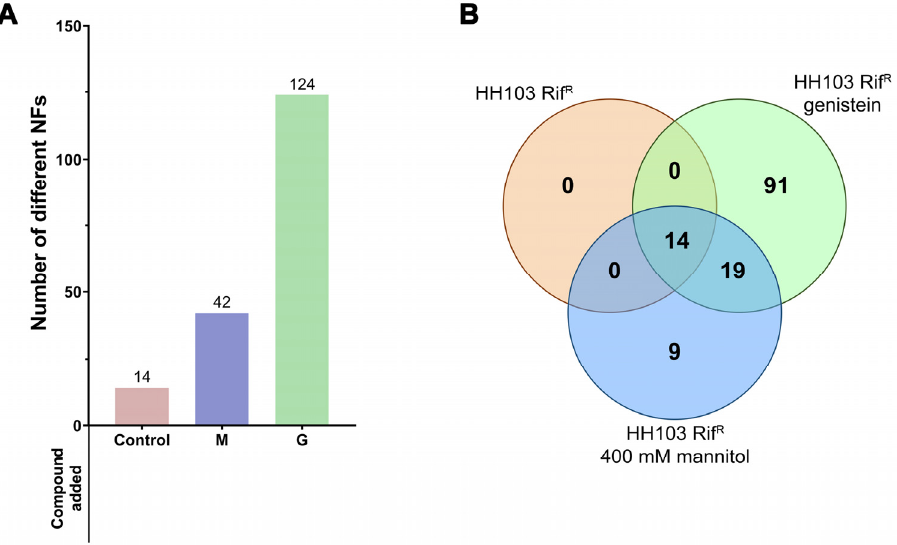
Figure 2. (A) Number of NFs produced by S. fredii HH103 grown in B - medium in the absence (Control) or presence of mannitol (M) or genistein (G). ( B ) Venn diagram of the sets of Nod factors produced by S. fredii HH103 grown in B - medium in the absence (orange circle) or presence of mannitol (blue circle) or genistein (green circle).